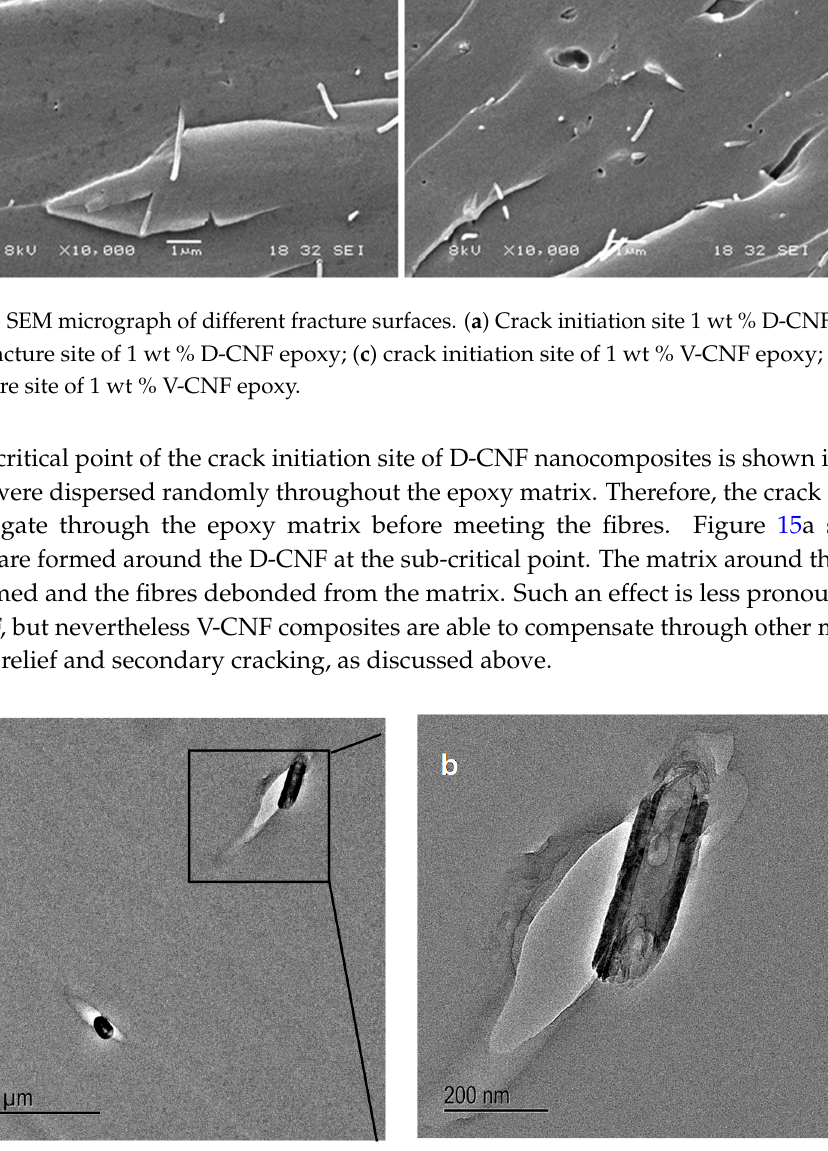
Figure 15. ( a ) TEM micrograph of sub critical point of crack initiation site showing debonding of D-CNF and epoxy; and ( b ) higher magnification of sub critical point of crack initiation site showing debonding of D-CNF and